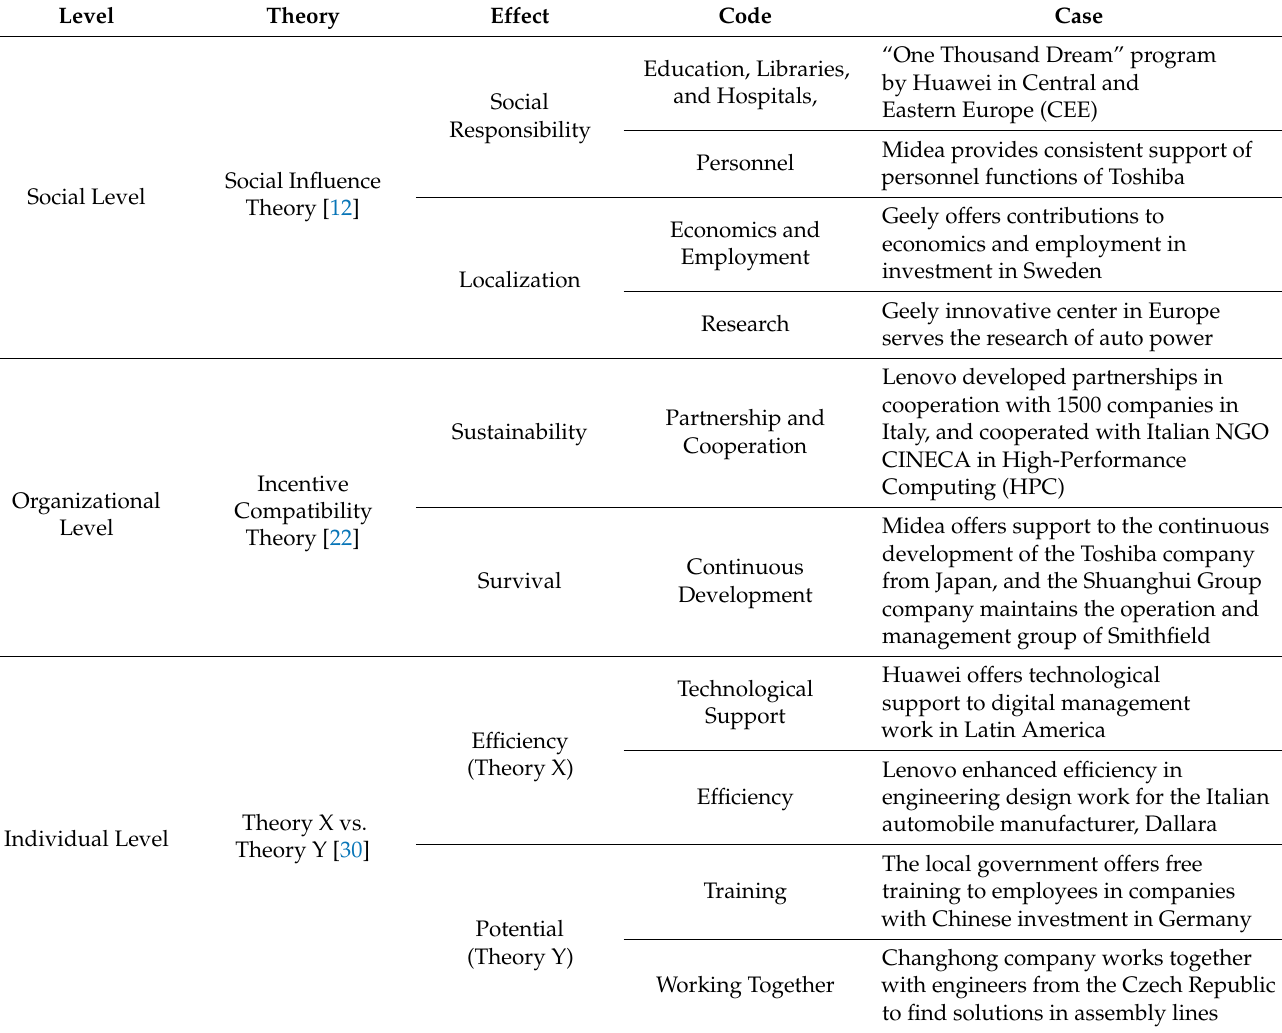
Table 1. Theoretical framework in cross-case study about the effect of FDI on